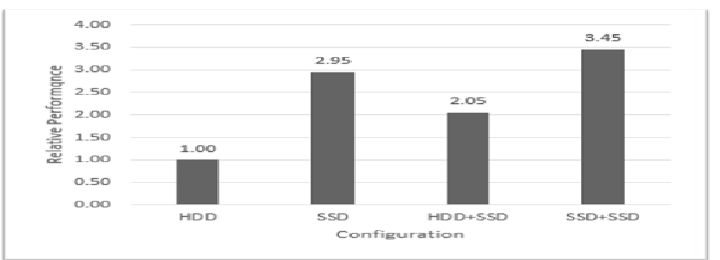
Figure 12. Effect of the normal/urgent separation: fast device, data-awareness, and parallelism enhance